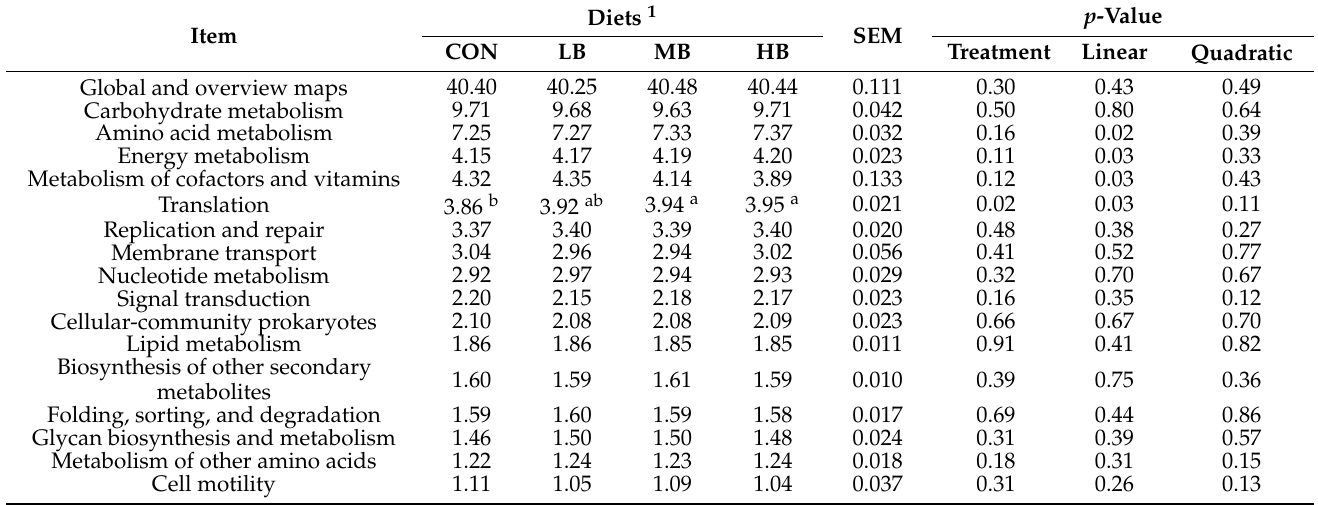
Table 6. Predicted fecal bacterial function, by PICRUSt analysis (KEGG level-2 pathways), of lactating Holstein cows fed diets containing by-products instead of forage (relative abundance >